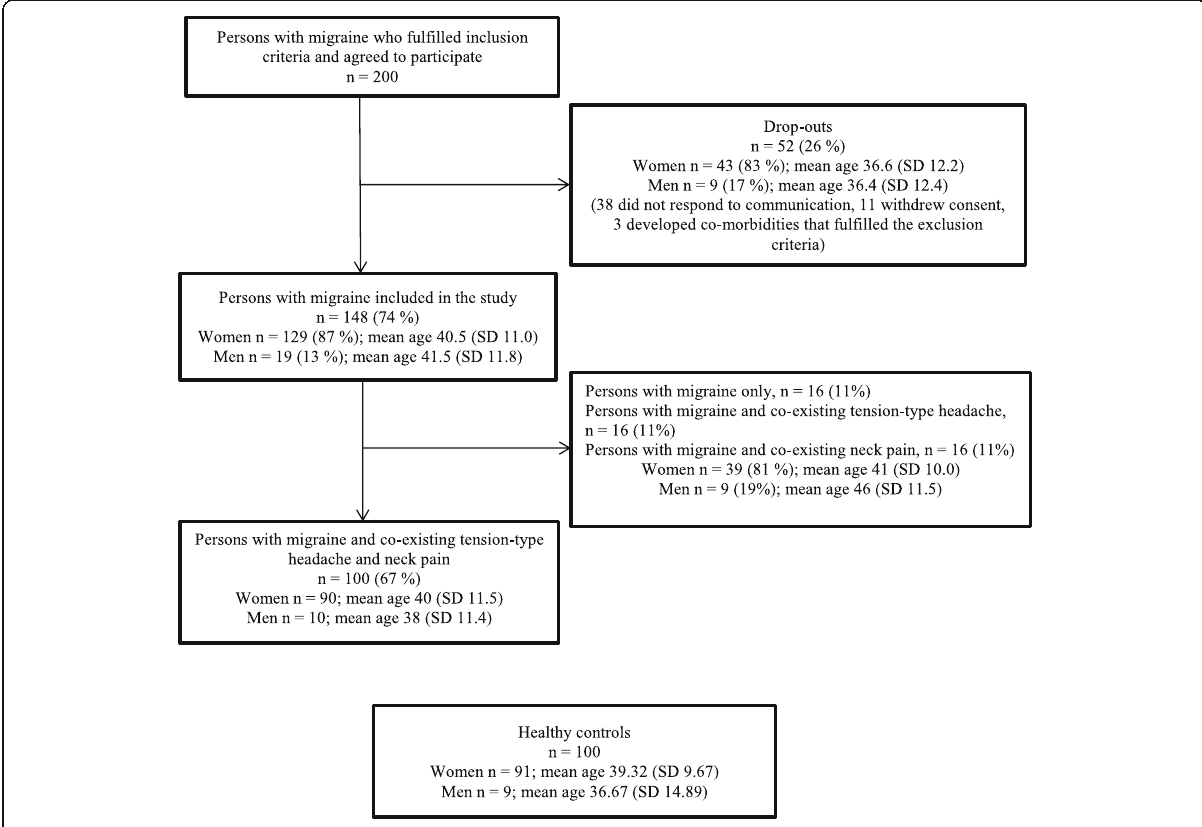
Fig. 1 Flow chart of the inclusion procedure of a clinic-based sample of persons with